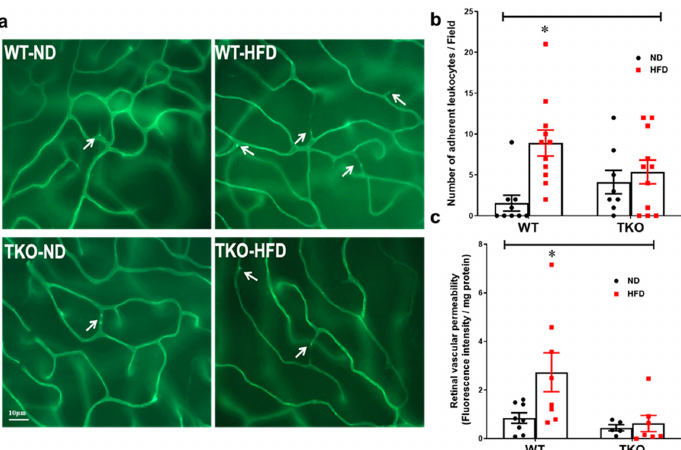
Figure 2. Deletion of TXNIP mitigates HFD-induced retinal leukostasis and BRB breakdown. ( a ) Representative pictures and ( b ) quantification of the number of adherent leukocytes occluding the poorly perfused retinal micro-vessels per field (indicated by white arrows) showed higher numbers in the WT-HFD group but had no significant effect on the TKO-HFD group compared with WT-ND group ( n = 8–11 mice/group; * p < 0.05 vs other groups). ( c ) Quantification of BSA-Fluorescence in the retina tissue was higher in the WT-HFD group whereas both TKO-ND and TKO-HFD groups had significantly lower levels of BSA-Fluorescence extravasation, respectively, compared with WT-ND group ( n = 5–9 mice/group; * p < 0.05 vs other groups). 2.3. Deletion of TXNIP Prevents HFD-Induced Retinal Inflammation and Expression of Cell Adhesion Molecules. Traditionally, leukostasis is provoked by expression of endothelial cell adhesion molecules. Expression of intercellular adhesion molecules-1 (ICAM-1) and vascular cell adhesion molecule-1 (VCAM- 1) was assessed after 8 weeks of HFD. As shown in Figure 3a,b, HFD significantly increased the expression of ICAM-1 (1.5-fold) and VCAM-1 (2.3-fold) in WT-HFD compared with WT-ND ( p < 0.05, n = 4–6). Deletion of TXNIP significantly mitigated the HFD-induced expression of adhesion molecules ( p < 0.05, n = 4–6).